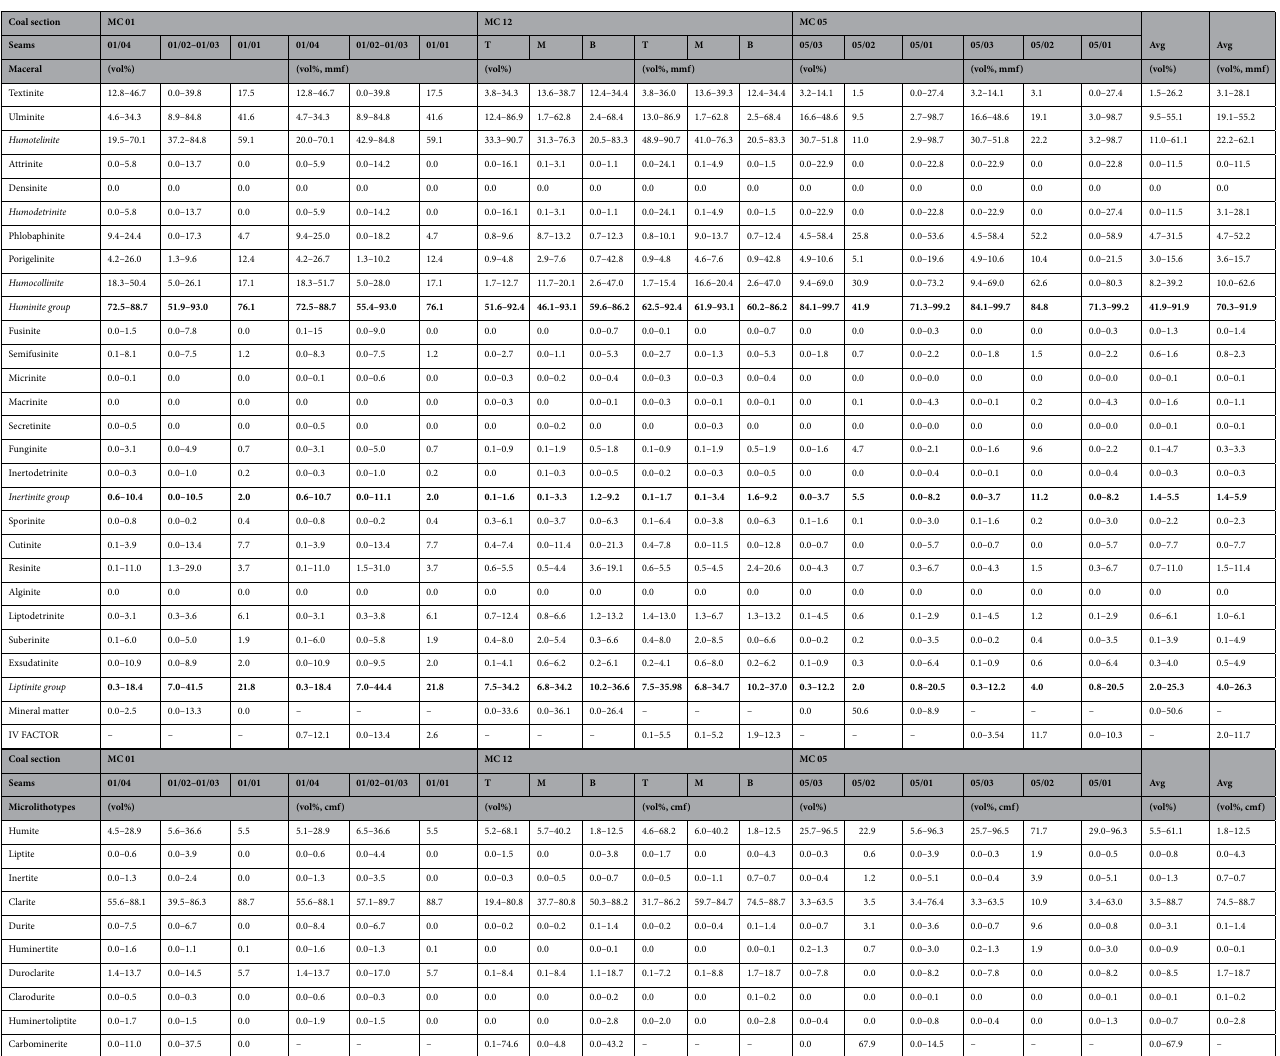
Table 1. The petrographic composition shows values in range and average (avg.) as total (vol%), and mineral-free basis (vol%, m.m.f.)/carbominerite free basis (vol%, c.m.f) of the intra-seams in the Mukah coals. Significant values are in bold. IV factor is also shown. T top, M middle, B bottom, IV factor inertinite– huminite/vitrinite factor by (inertinite × 100)/(inertinite +